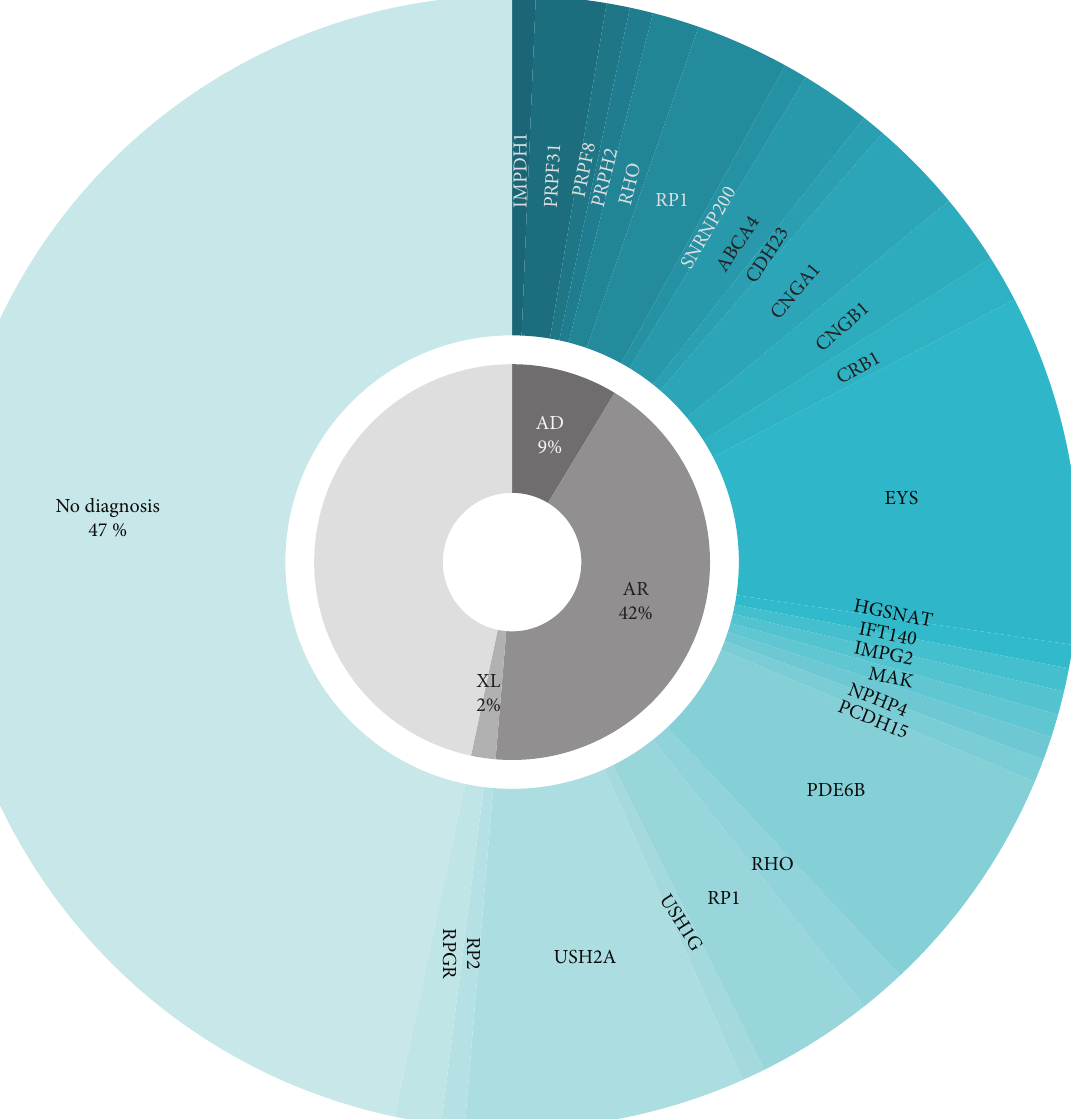
Figure 1: A mutational spectrum of the 150 Korean patients with retinitis pigmentosa. AD, autosomal dominant; AR, autosomal recessive; XL, X-linked